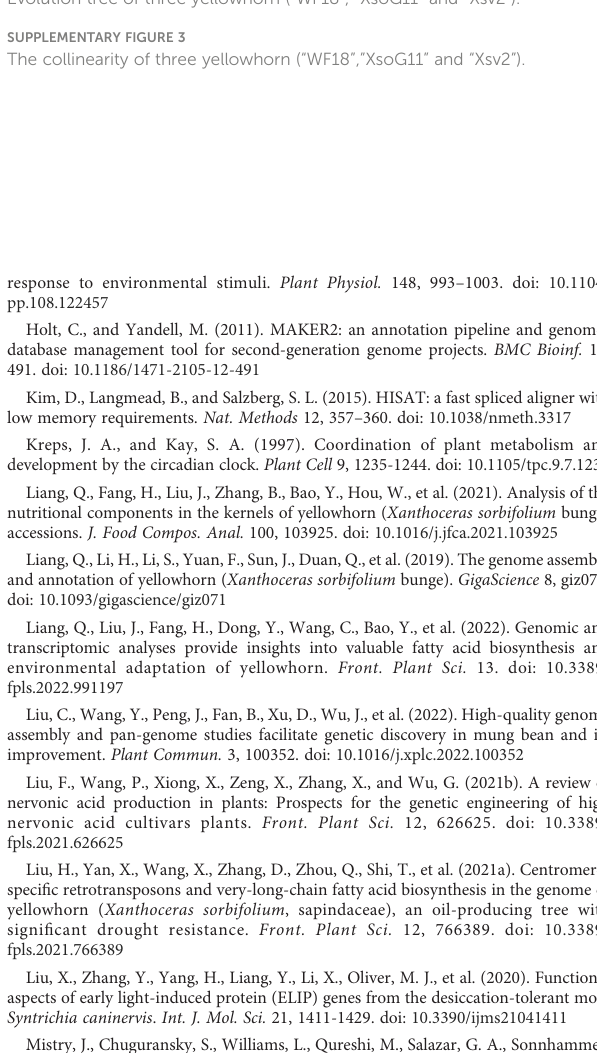
SUPPLEMENTARY FIGURE 1 XsoG11 yellowhorn tree used in this study. SUPPLEMENTARY FIGURE 2 Evolution tree of three yellowhorn ( “ WF18 ” , “ XsoG11 ” and “ Xsv2 ” ). SUPPLEMENTARY FIGURE 3 The collinearity of three yellowhorn ( “ WF18 ” , ” XsoG11 ” and “ Xsv2 ”